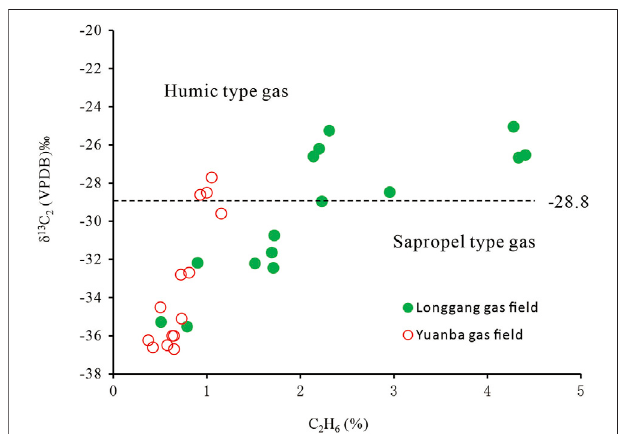
FIGURE 2 | Comparison of carbon isotope characteristics of Permian – Triassic natural gas in the Sichuan Basin.